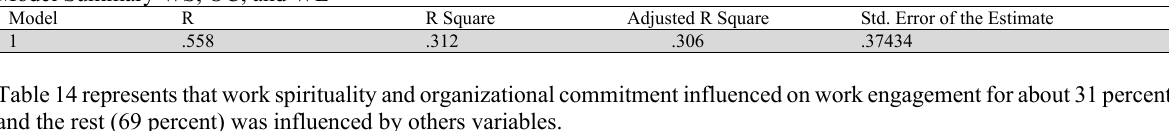
Model Summary WS, OC, and WE Model